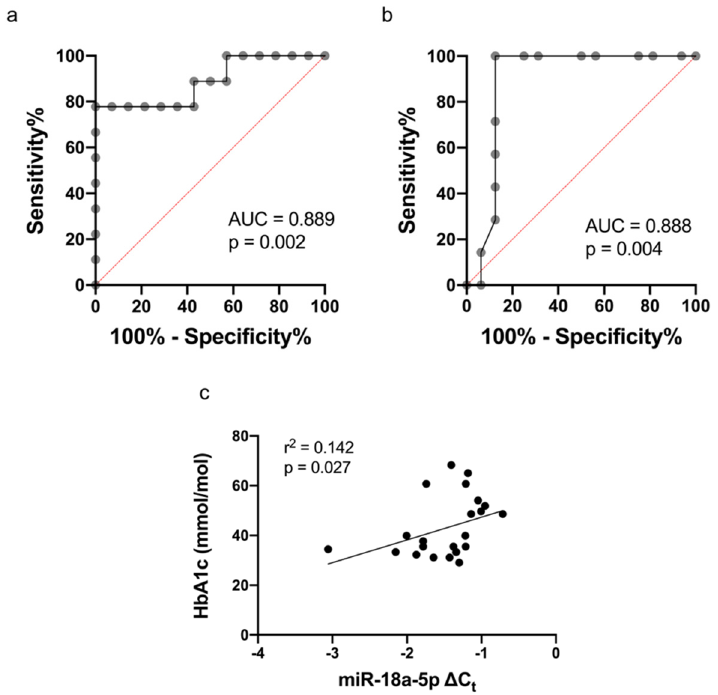
Figure 3. ( a ) Receiver operating characteristic (ROC) curve analysis of miR-18a-5p in discriminating T1DM patients from healthy controls; ( b ) ROC curve analysis of HbA1c to indicate upregulated miR-18a-5p expression in CFU-Hill’s colonies; ( c ) Correlation between miR-18a-5p in CFU-Hill’s colonies and HbA 1c as a parameter to evaluate glycemic control (r 2 = 0.142, p = 0.027). ROC curve analysis was performed to determine optimal cut-off values, whilst linear regression analysis was performed to assess the correlation between miR-18a-5p and HbA 1c . HbA1c: glycated hemoglobin.